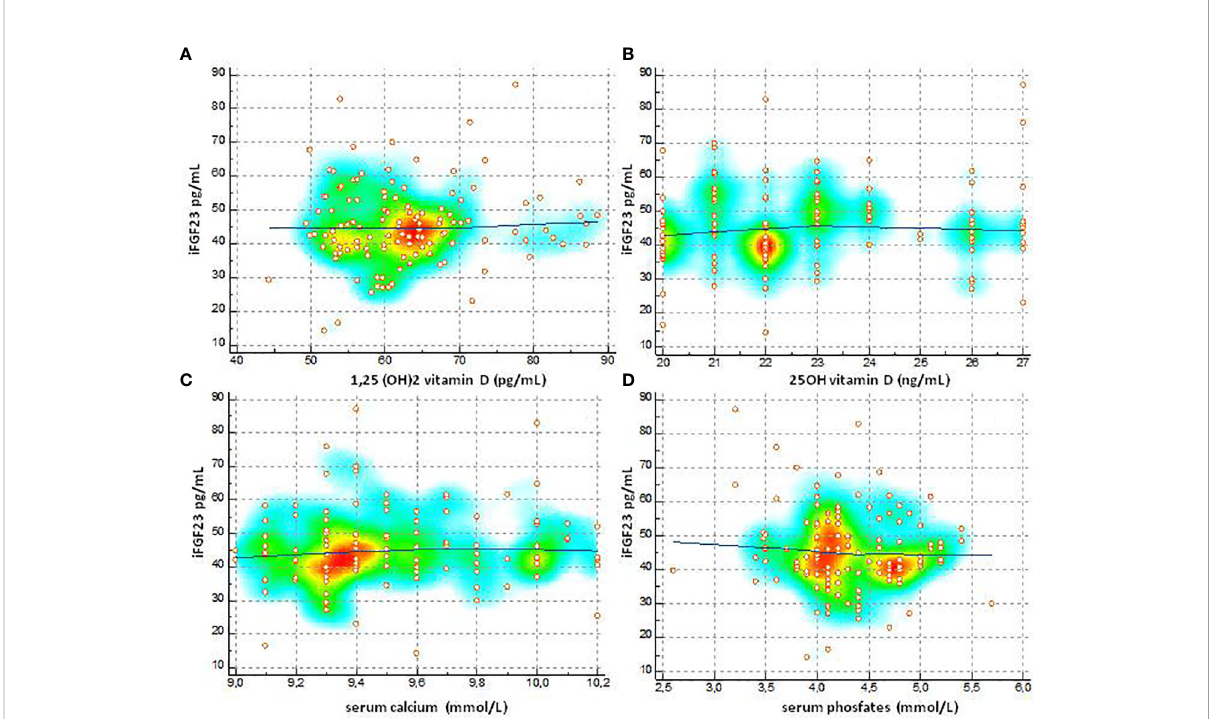
FIGURE 6 Degree of relationship between IFGF23 towards variables 1-25 (OH) 2D, 25 (OH) D, total calcium and phosphate (A) Spearman's (rho) 0.0489, 95% CI for rho -0.132 to 0.226, P=0.5960, (B) Spearman's (rho) 0.104, 95% CI for rho 0.0770 to 0.278, P = 0.2597, (C) Spearman's (rho) 0.093, 95% CI for rho -0.0967 to 0 276, P = 0.3359, (D) Spearman's (rho) -0.787, 95% CI for tho -0.254 to 0102,